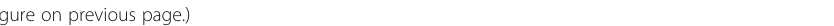
Table 1 Comparison between static and dynamic MRI in evaluation of disc position and mobility in the examined joints